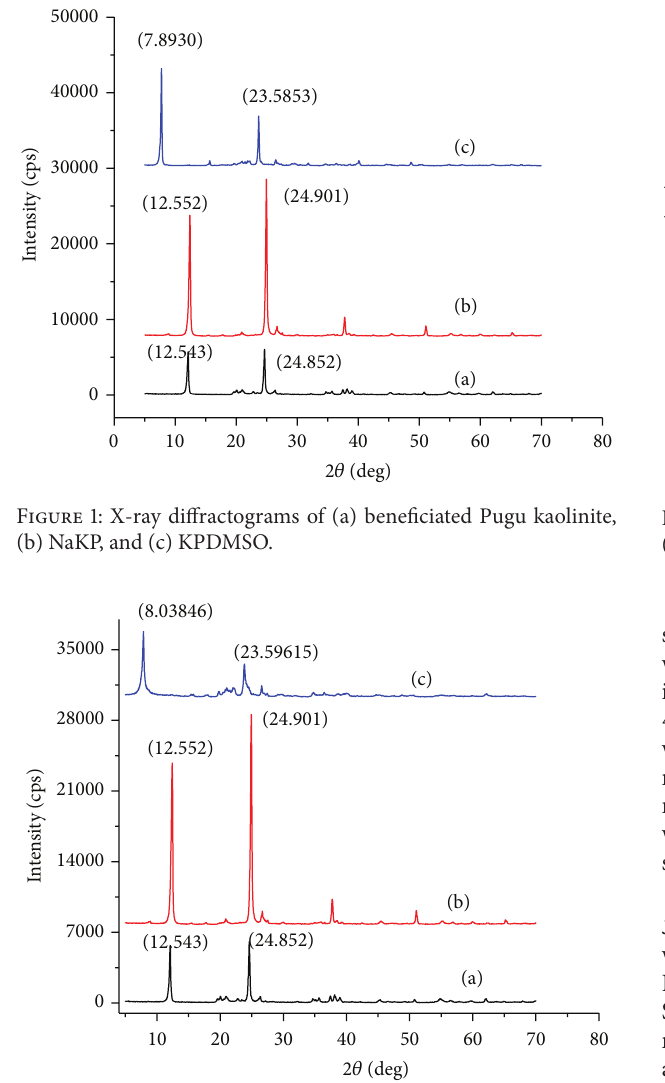
Figure 2: X-ray diffractograms of (a) beneficiated Pugu kaolinite, (b) NaKP, and (c) KPDM. Table 6: Analysis of particle sizes from Scherrer equation .